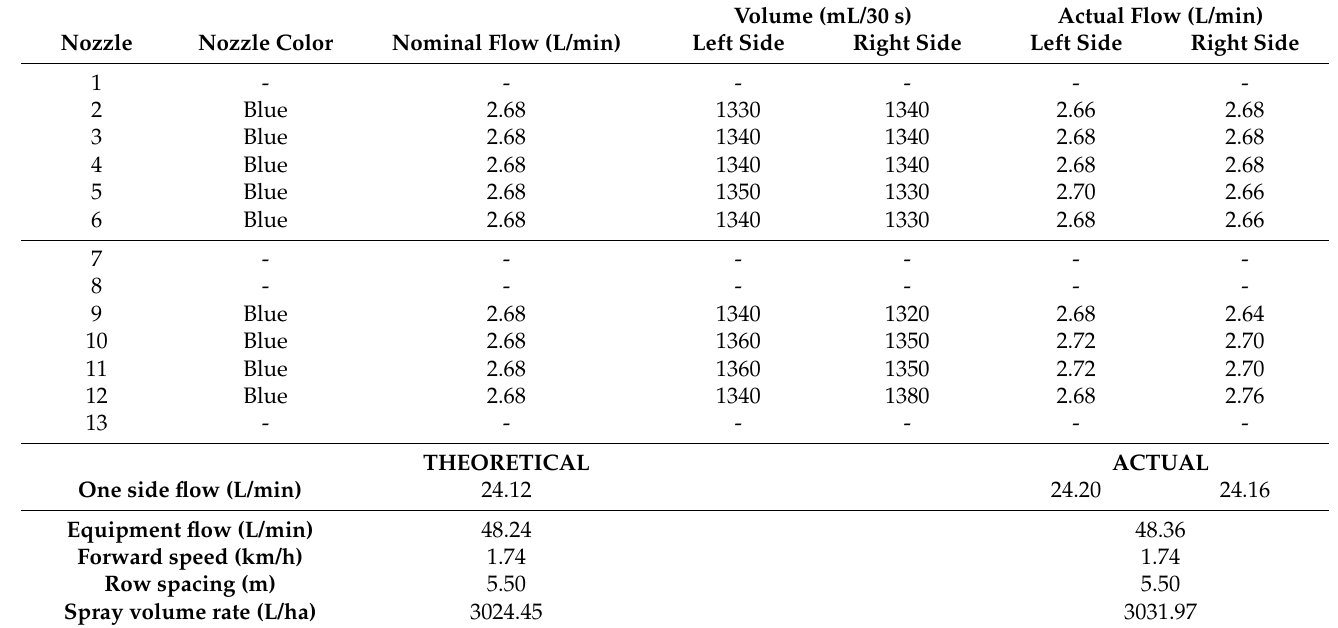
Table A15. Selection and calibration of nozzles for the C2 sprayer, with the following configuration: Adjusted to the vegetation/High & Low fan speed/High spray volume rate/Drift-reducing nozzles (Coarse)/Pressure: 15 bar.